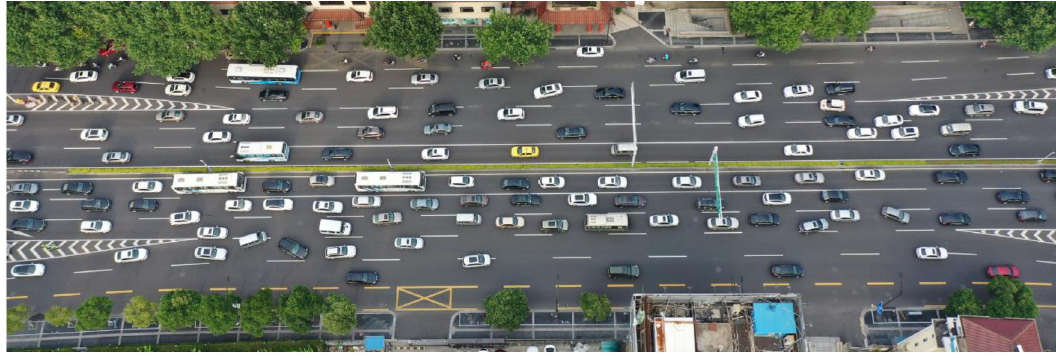
Fig 1. Field picture of the studied